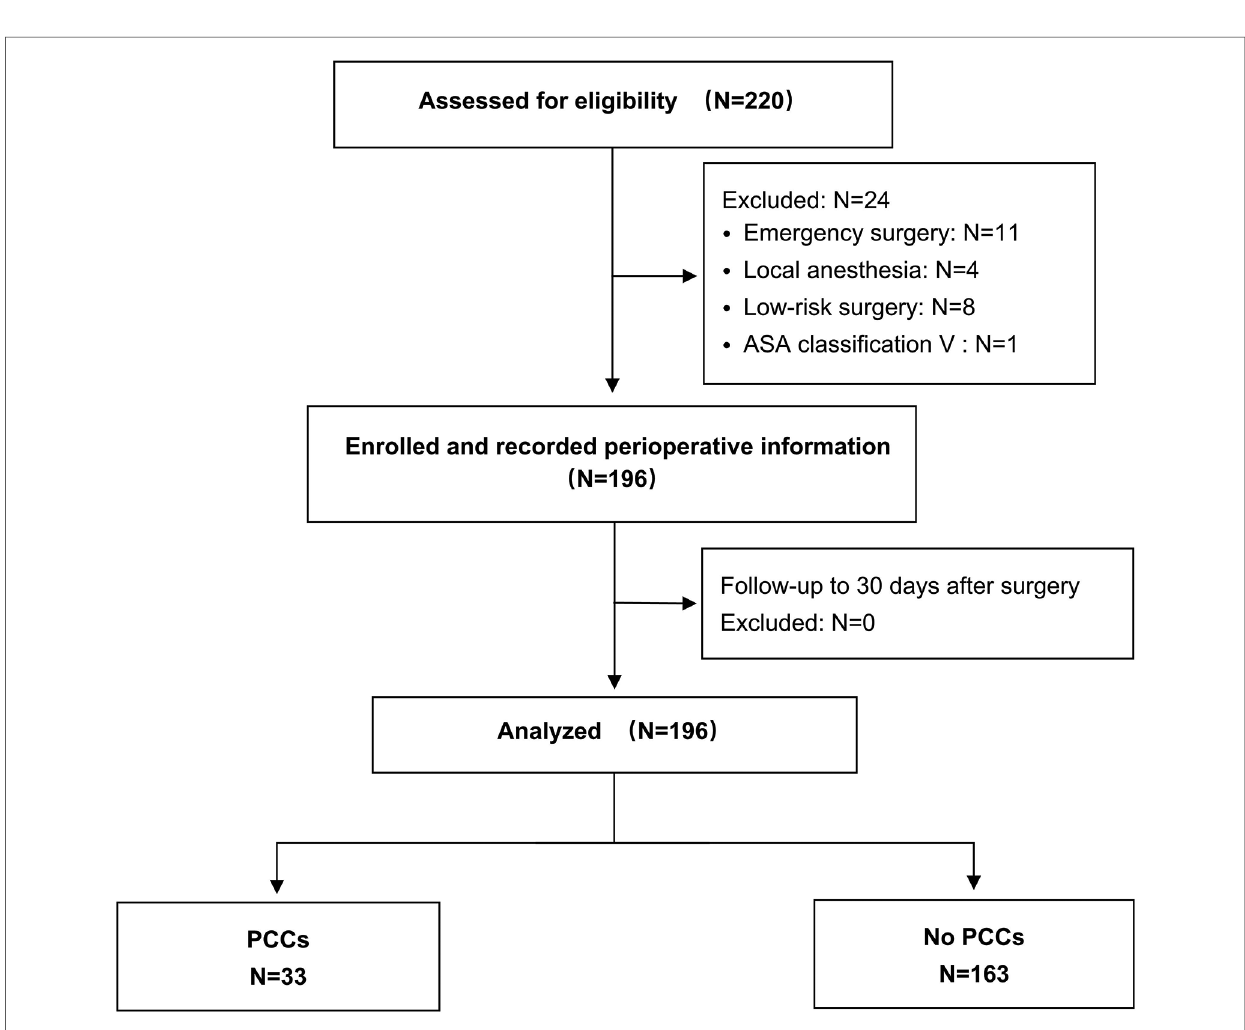
FIGURE 1 Flow chart of patient enrollment and analysis. PCCs, perioperative cardiac